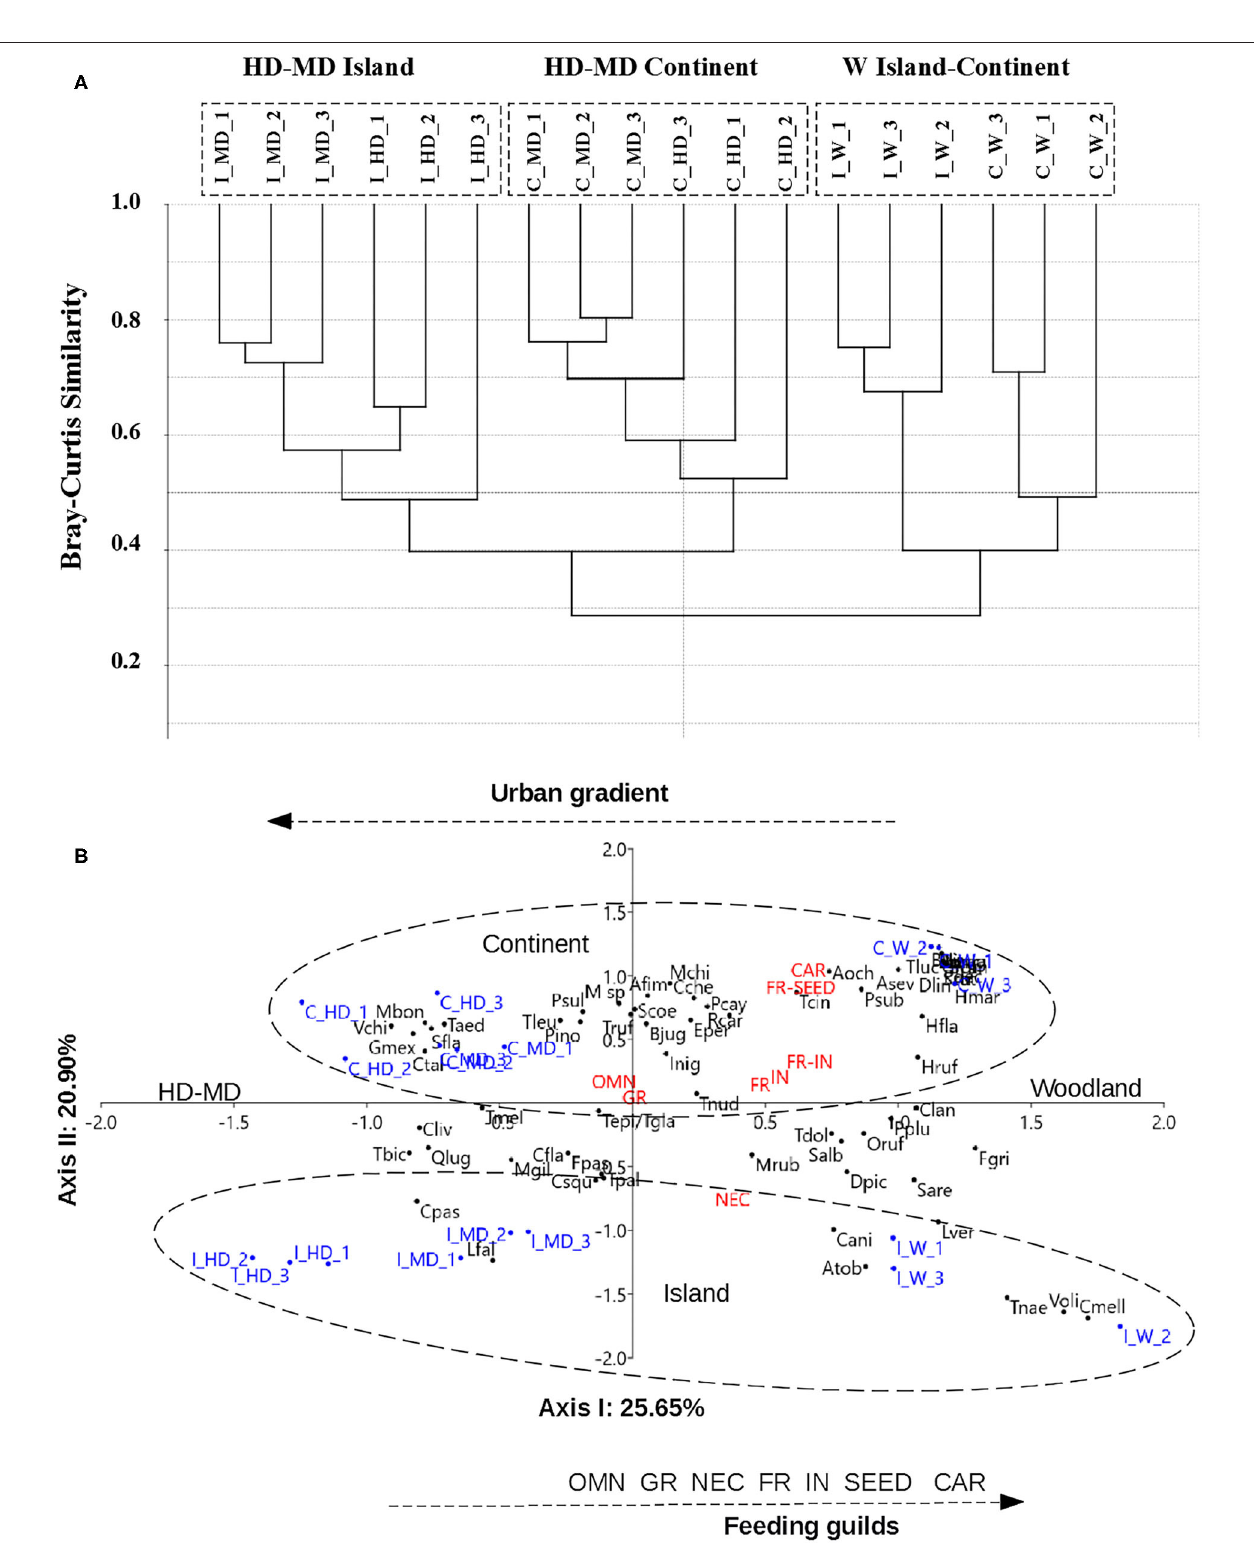
FIGURE 2 | (A) Hierarchical clustering dendrogram from the Bray–Curtis similarity analysis in the three levels of urban gradient (i.e., HD, MD, and W) in Continent and Island. (B) Correspondence analysis based on the frequency of bird species along the urban gradient in Continent and Island with 65 widespread species recorded at least two times in one region. For the acronyms of bird species, refer to Bird List in Supplementary Material 2 . For the acronyms of localities, refer to Table 1 . C, Continent; I, Island; W, remnant woodland; MD, medium density; HD, high density. Feeding guilds: OMN, omnivores; GR, granivores; IN, insectivores; FR, frugivores; NEC, nectarivores; SEED, seedeaters; and CAR, carnivores.